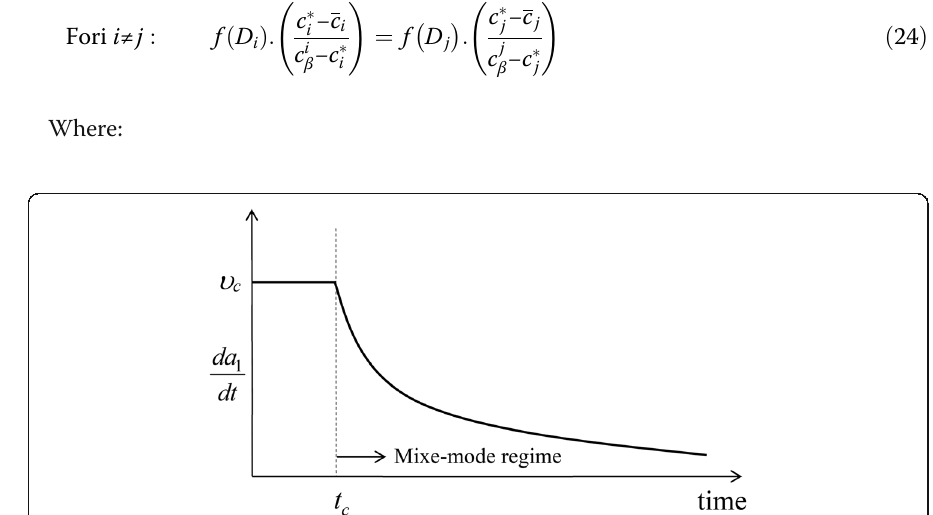
Fig. 2 Expected evolution of the interfacial velocity of a precipitate growing in a supersaturated